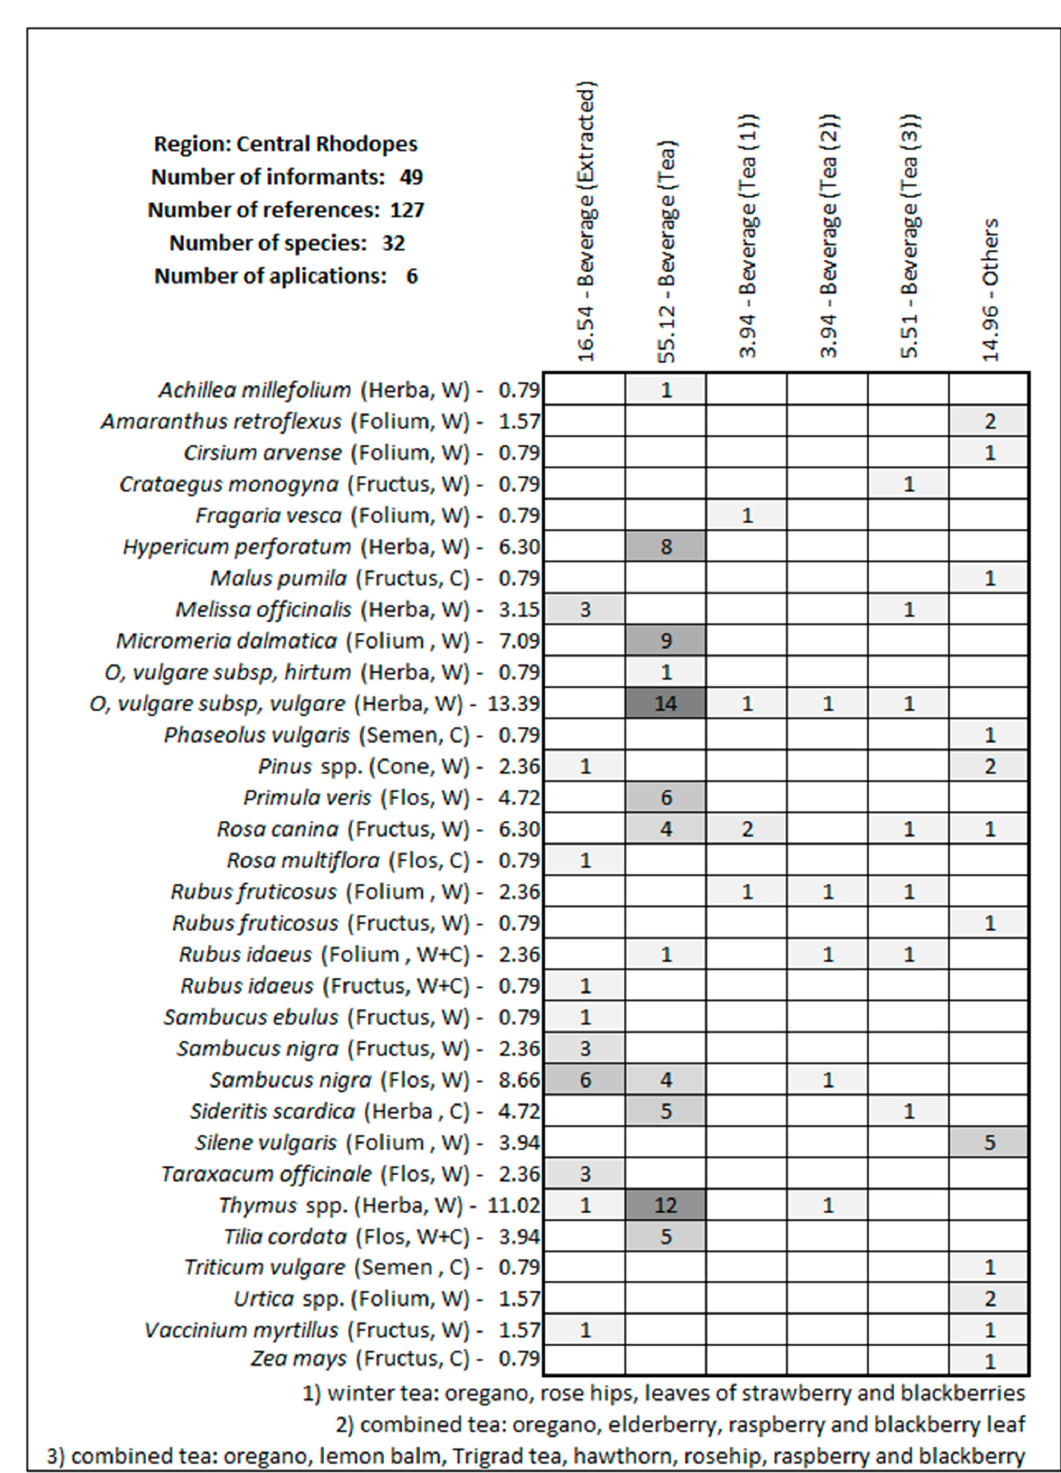
Figure 6. Nomogram of the medicinal plants with prophylactic application in the Central Rhodopes. Legend: abscissa/horizontal axis of the nomograms depicts the conditions for which the informants apply the medicinal plants, as well as the way of processing the plant raw material; ordinate vertical axis shows the medicinal plants Genus species (used part, wild/cultivated)—UV (%); (1) winter tea: oregano, rose hips, leaves of strawberry and blackberries, (2) combined tea: oregano, elderberry, raspberry and blackberry leaf, (3) combined tea: oregano, lemon balm, Greek mountain tea, hawthorn, rosehip, raspberry and